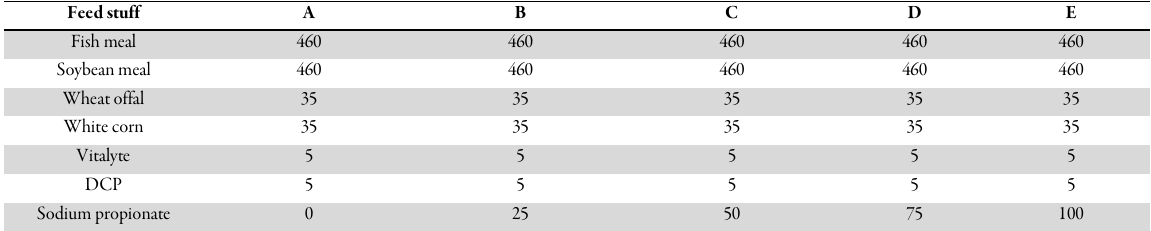
Table 1. Experimental diet formulation with different levels of sodium propanoate (in grams per 15 kg diet) Feed